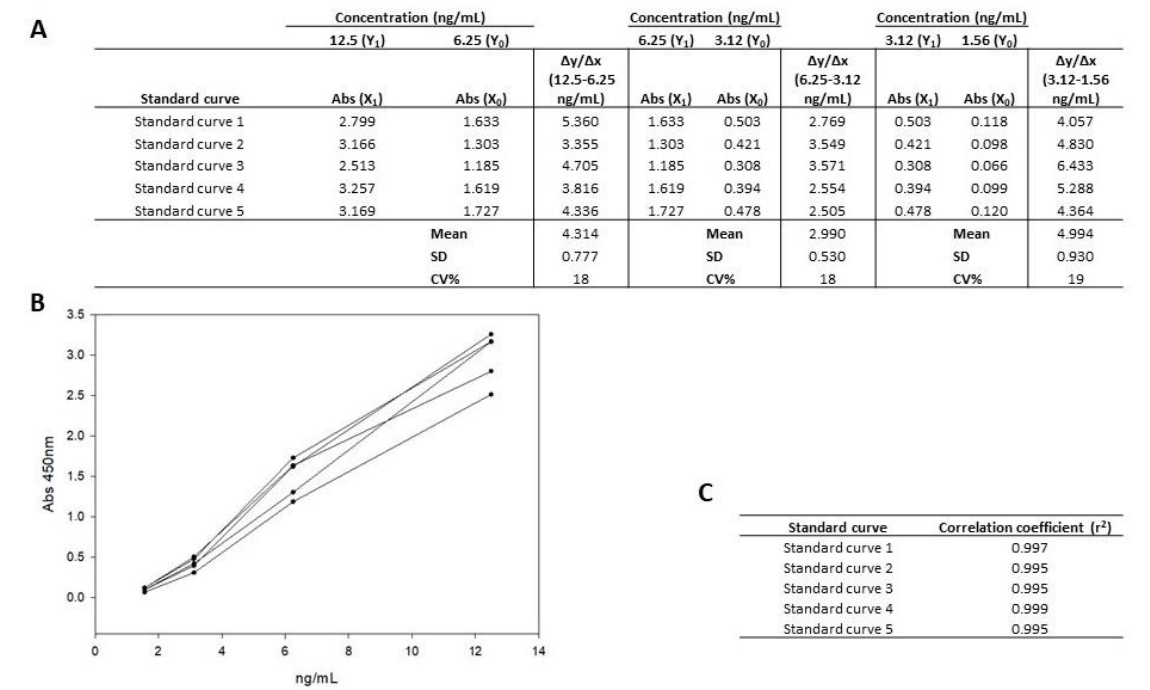
Figure 2. ( A ) Calculation of slopes ( ∆ y/ ∆ x) between the different concentrations of the curve and the correlation coefficient (r2). The slope ( ∆ y/ ∆ x) between concentrations was calculated using the equation; ∆ y/ ∆ x = (Y1 − Y0)/(X1 − X0); Y = concentration (ng/mL 33-mer), and X = absorbance. ( B ). Polynomial representation of 33-mer concentrations (12.5 and 1.56 ng/mL). ( C ). Correlation coefficient (r2) calculated from the polynomial approximation of the standards analyzed. Abs, absorbance; CV%, coefficient of variation; SD, standard deviation.